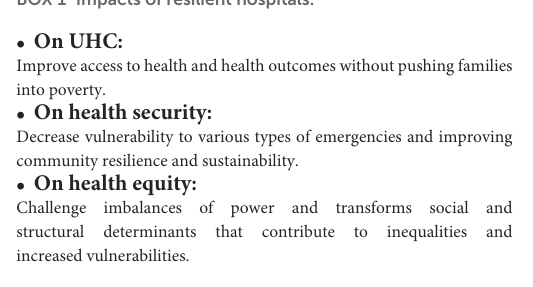
TABLE 2 Capacities in systematic and scoping reviews on hospital and health systems resilience (see Annex 4 for a full table of comparative